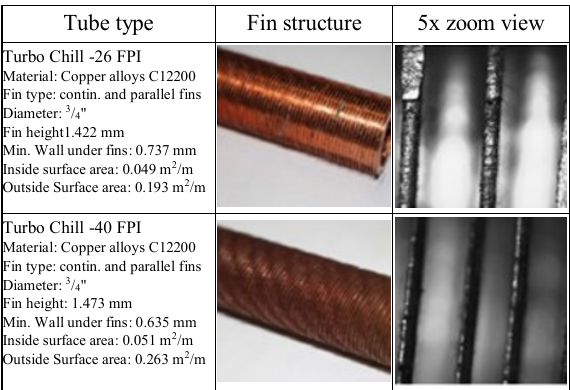
Table 1. Geometric parameters of the evaporator tubes investigated by Thimmaiah et al.